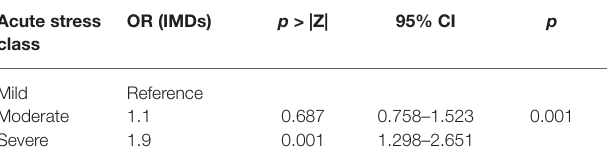
TABLE 4 | Association between acute stress and IMDs.